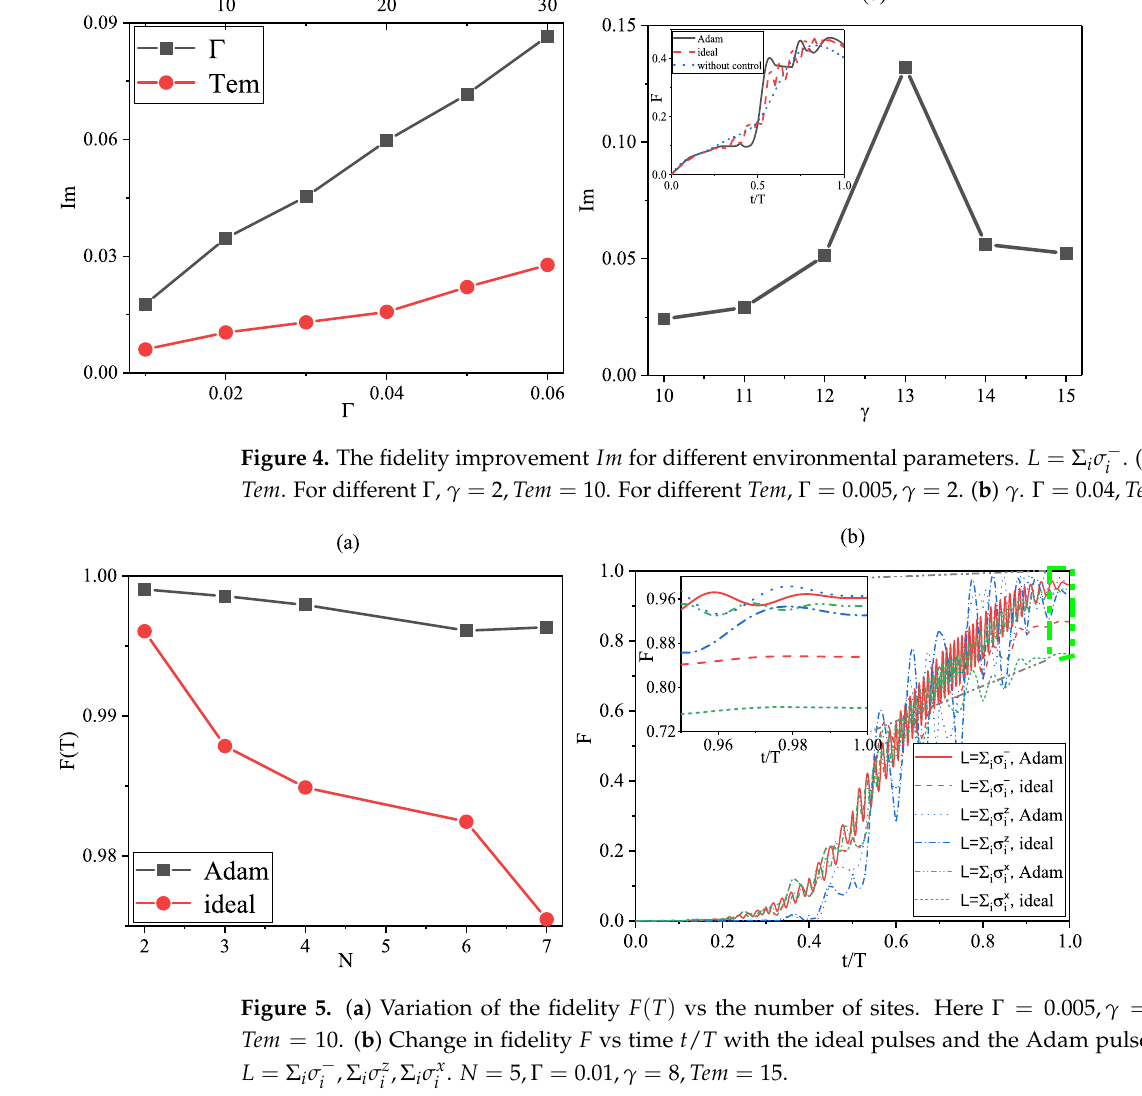
Figure 5. ( a ) Variation of the fidelity F ( T ) vs the number of sites. Here Γ = 0.005, γ = 2, and Tem = 10. ( b ) Change in fidelity F vs time t / T with the ideal pulses and the Adam pulses when L = Σ i σ − . N = 5, Γ = 0.01, γ = 8, Tem = , Σ i σ x , Σ i σ z i i i